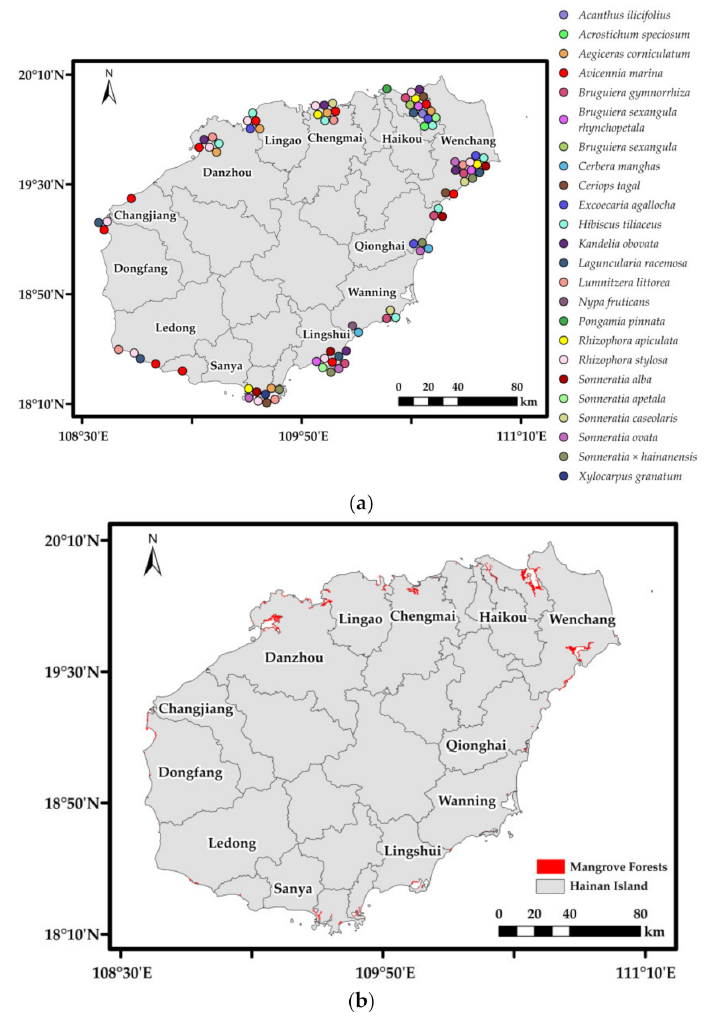
Figure 1. Ground survey data in 2020. ( a ) Distribution of dominant mangrove forest tree species in the Hainan Island. ( b ) Distribution range of mangrove forests in the Hainan